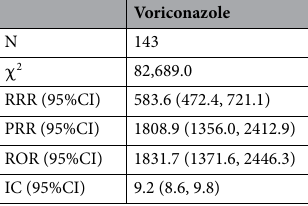
Table 2. The association between periostitis and voriconazole. RRR relative reporting ratio, CI confidence interval, PRR proportional reporting ratio, ROR reporting odds ratio, IC information